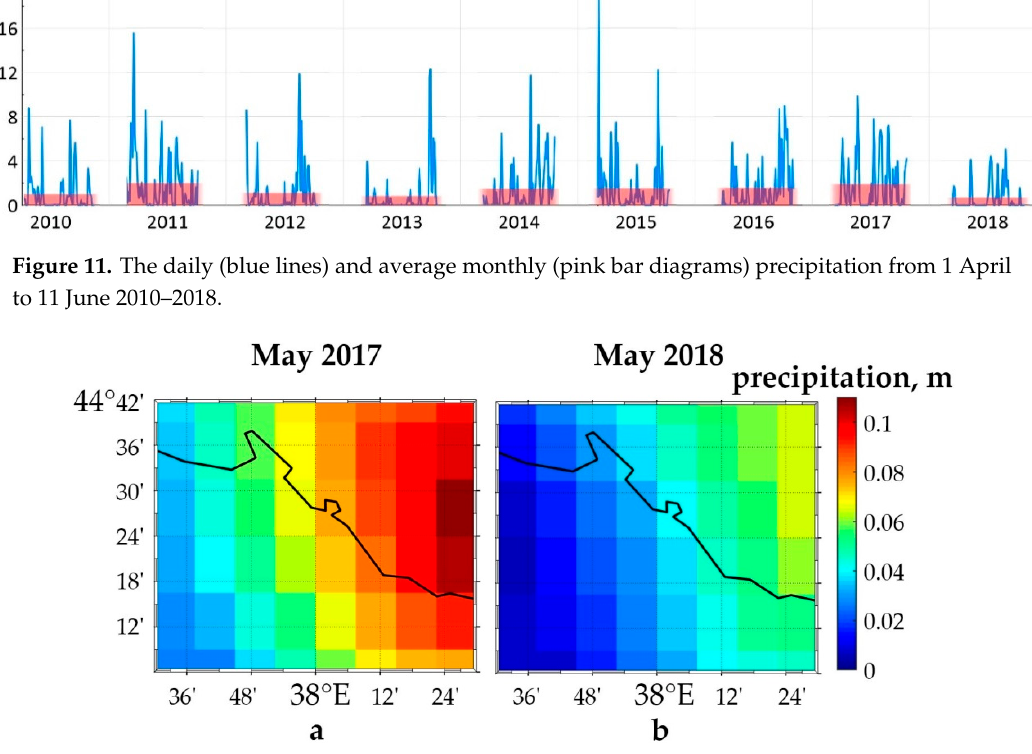
Figure 12. Distribution of average daily precipitation values in the catchment area in the period from 1 May to 31 May 2017 ( a ) and 2018 ( b ).